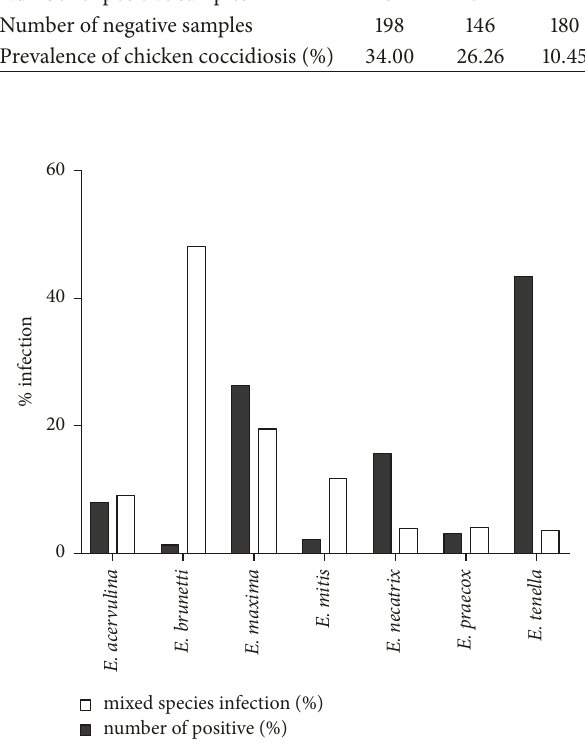
Figure 2: Eimeria species identification in positive faecal samples.